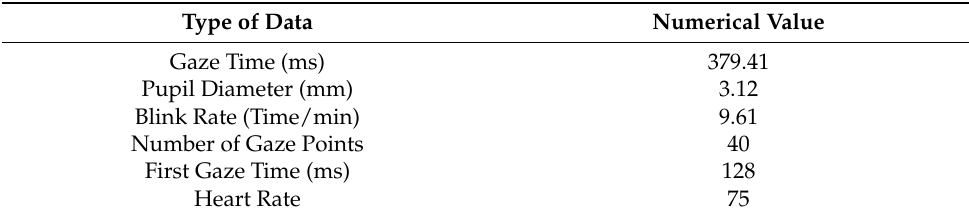
Table 8. Multi-channel modified MR display interaction system eye movement and peripheral physiological characteristics data.